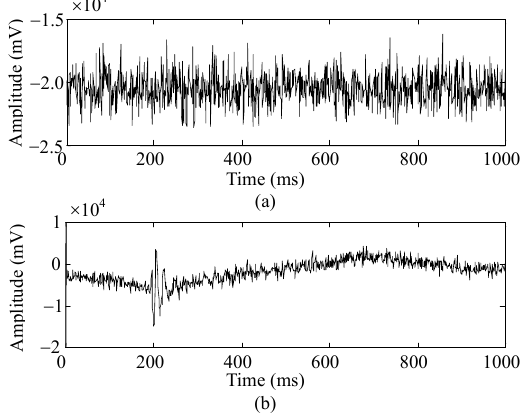
Fig. 3 Intrusion signals: (a) signal I and (b) signal Q.